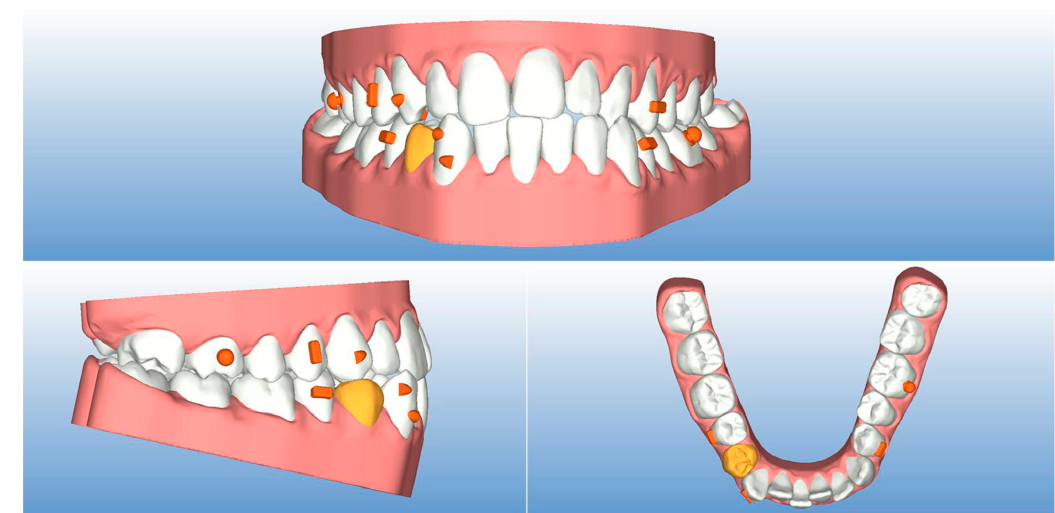
Figure 3. Step 0 of the virtual treatment plan (extracted tooth in yellow, attachments and buttons for elastics in orange).